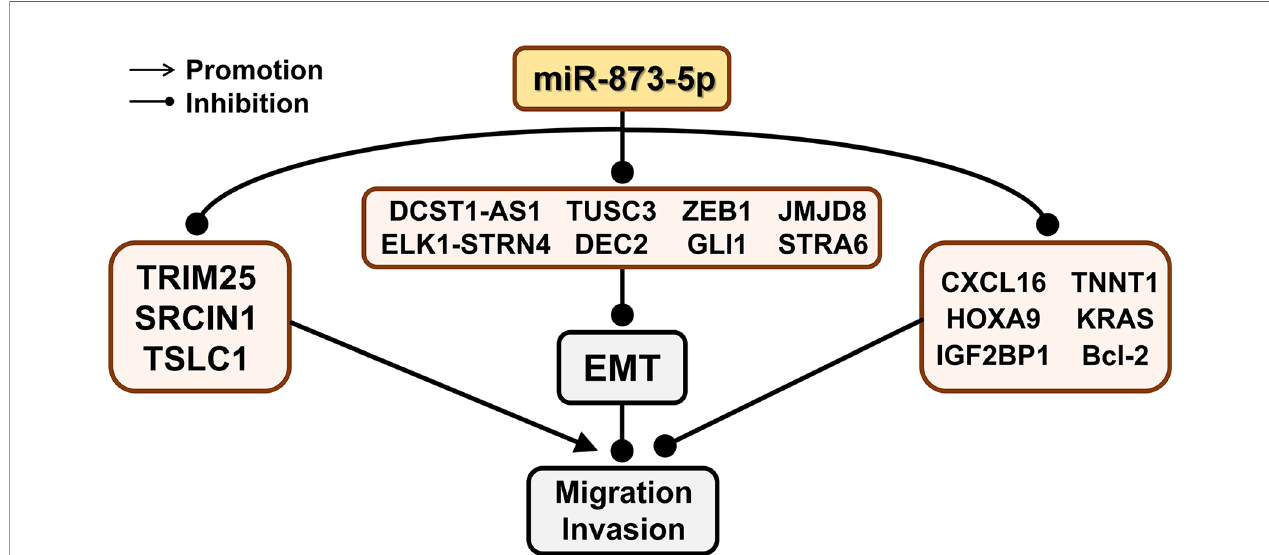
FIGURE 5 | The effect of miR-873-5p target genes on EMT, migration, and invasion of cancer cells. miR-873-5p inhibits the EMT process by inhibiting the expression of ZEB1, TUSC3, DCST1-AS1, JMJD8, ELK1-STRN4, GLI1, STRA6, and DEC2. MiR-873-5p targets TRIM25, SRCIN1, and TSLC1, and promotes cell migration and invasion. In addition, miR-873-5p inhibits the migration and invasion of cancer cells by targeting CXCL16, TNNT1, IGF2BP1, Bcl-2, TNNT1, and